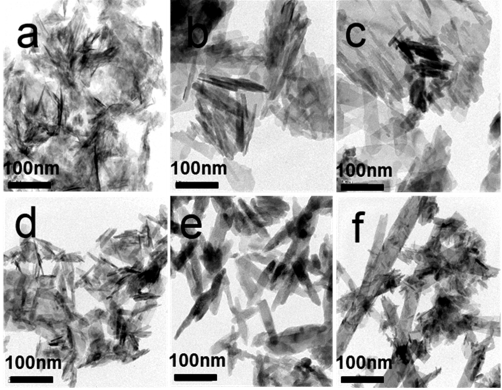
Figure 4. TEM micrographs of HA samples: ( a ) CS1000-1; ( b ) CS3000-1; ( c ) CS5000-1; ( d ) CS1000-2; ( e ) CS3000-2; ( f ) CS5000-2.